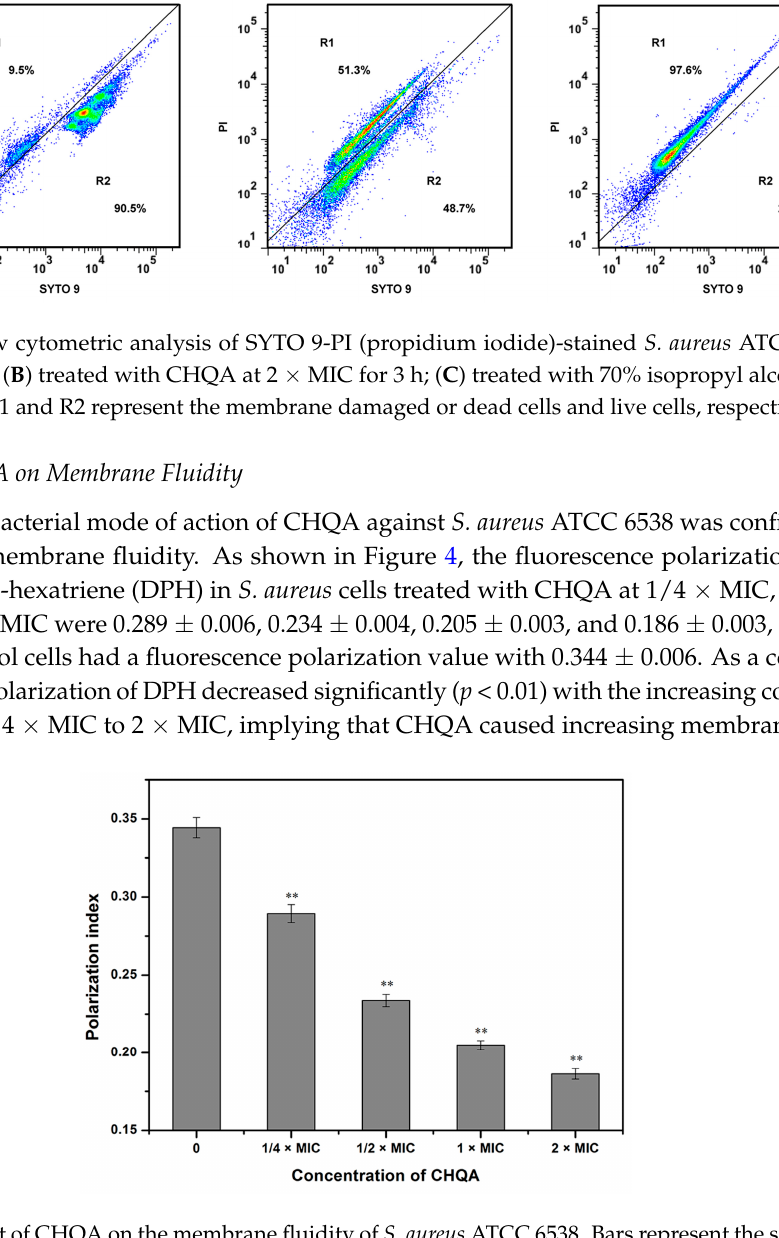
Figure 4. Effect of CHQA on the membrane fluidity of S. aureus ATCC 6538. Bars represent the standard deviation ( n = 3). ** p < 0.01.